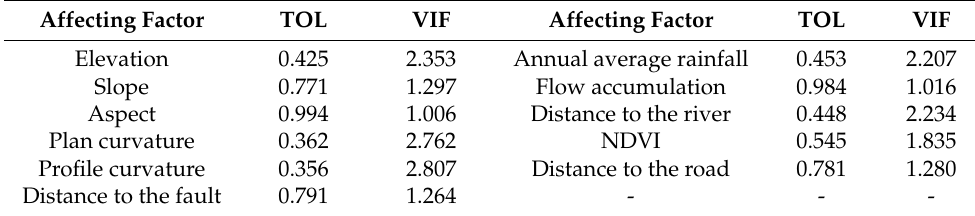
Table 2. Multicollinearity results of affecting factors.